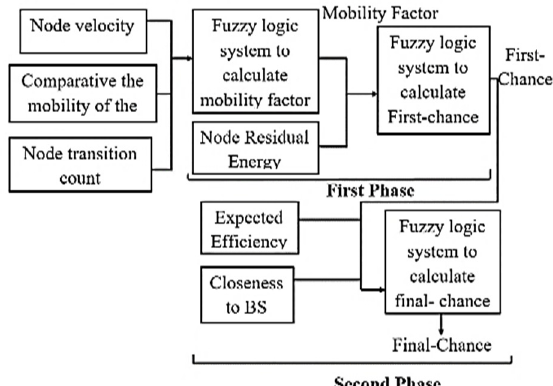
Fig. 8. Two Phase Fuzzy Logic System for Cluster Head Election